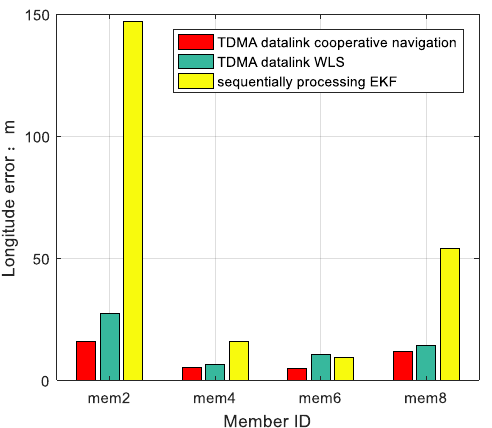
Figure 9. RMS longitude error comparison between TDMA datalink cooperative navigation, sequentially processing EKF, and TDMA datalink WLS.